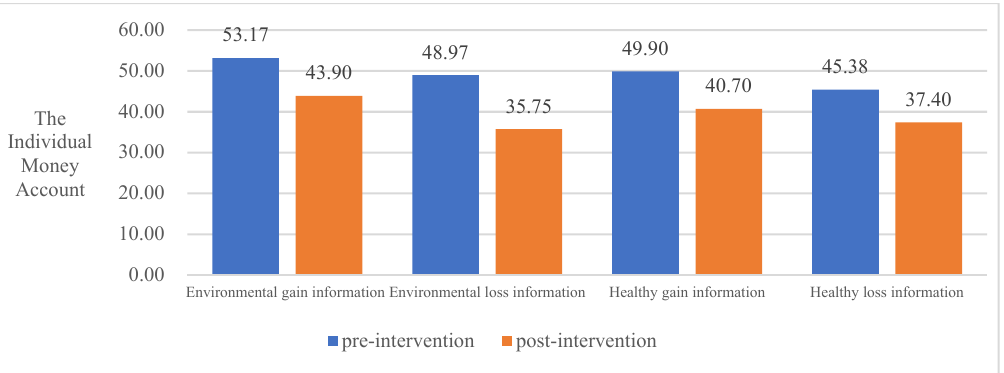
Figure 2. The impact of different information frameworks on the Individual Money Account.